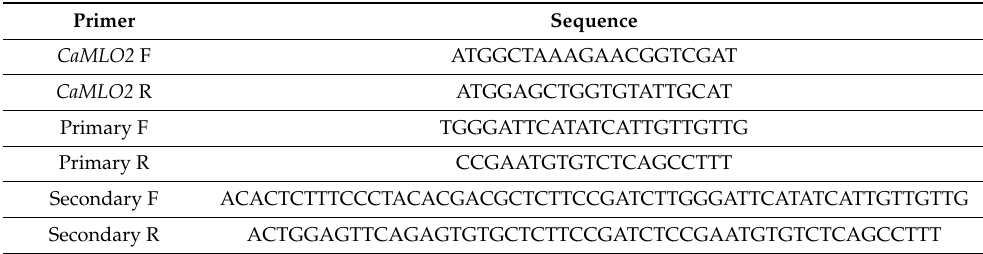
Table 2. Primers used in targeted deep